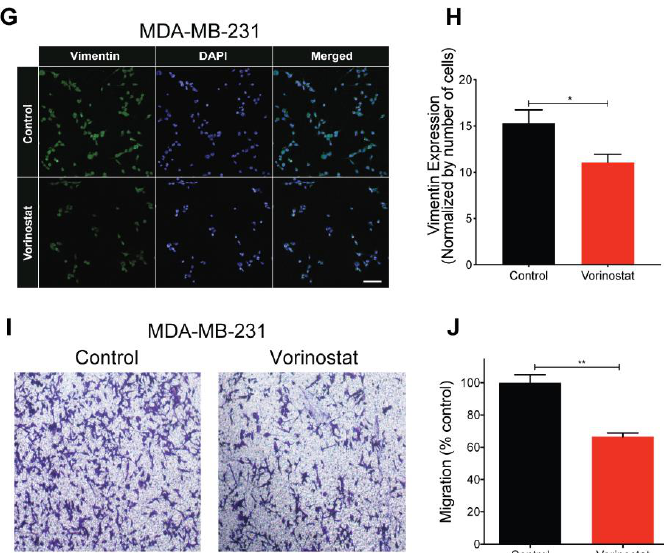
Figure 3. HDAC inhibitors promote mesenchymal to epithelial transition (MET) phenotype TNBC cells. ( A ) Schematic showing HDAC inhibitors promote MET. Epithelial and mesenchymal states are characterized by gene expression markers that increase or decrease, as indicated, upon transition between states. ( B , C ) Vimentin mRNA, determined by qPCR, decreased following treatment of MDA-MB-231 (B) and Hs578T ( C ) with vorinostat (2.5 µM) and romidepsin (5 nM) for 24 h. n = 3. ( D ) Vimentin protein expression (vorinostat (2.5 µM) and romidepsin (5 nM) for 24 h) was detected using Western blotting in the indicated TNBC cell lines; GAPDH was used as a loading control. ( E , F ) Quantitation of Western blots ( n = 3) by densitometry. ( G ) Representative confocal microscope images showing immunofluorescence staining of vimentin in MDA-MB-231 cells treated with vehicle (control) or vorinostat (2.5 µM) for 24 h. (40× magnification; scale bar, 50 µm). ( H ) Vimentin staining was quantified by ImageJ software (National Institute of Health, Bethesda, MD, USA), and divided by number ( n ) of cells, n = 352 in control, n = 141 for vorinostat. ( I ) Representative microscope images of MDA-MB-231 cells treated with vehicle or vorinostat (2.5 µM) for 24 h, in Boyden chamber (10× magnification). ( J ) Migration was quantified by ImageJ software from 3 images for each condition. Significance was determined by Student t -test, ** p < 0.01, * p < 0.05, ns p > 0.05.